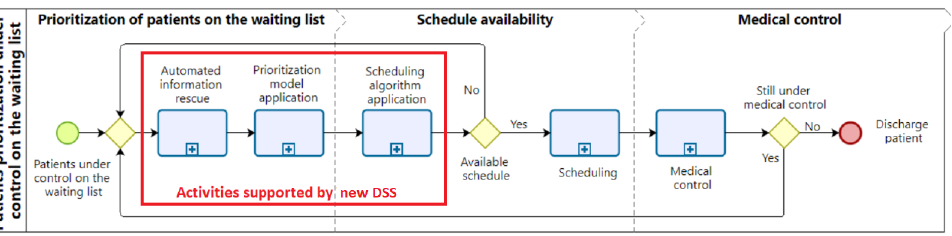
Figure 6. Diagram of the prioritization process of patients under medical management using the new DSS